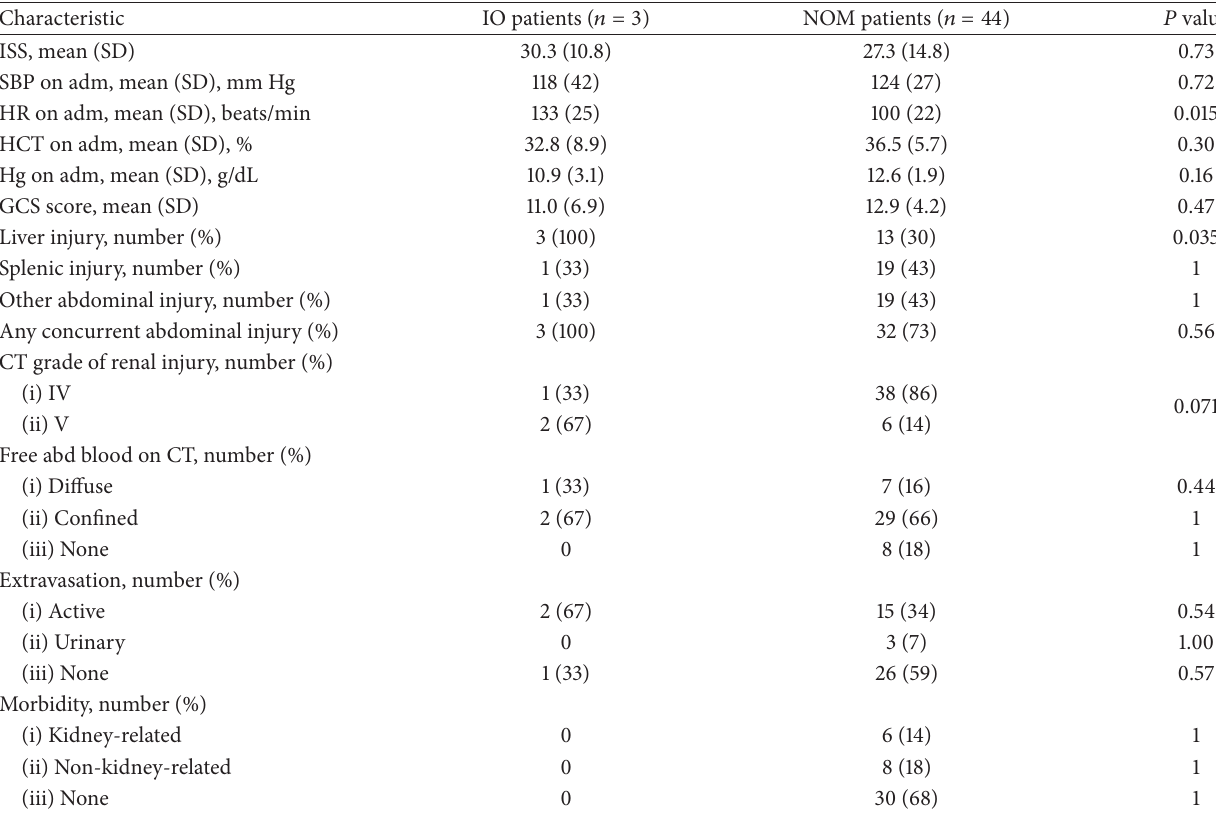
Table 1: Preoperative characteristics in IO versus NOM patients.